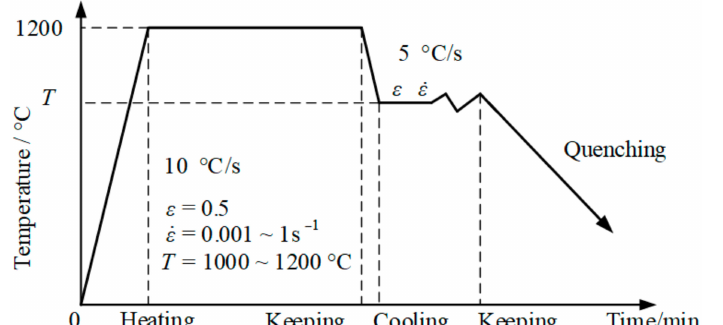
Figure 4. Sample of stress–strain curves: ( a ) common cylindrical specimen at mon cylindrical specimen at · ε = 0.001 s − 1 ; ( e ) SCS at